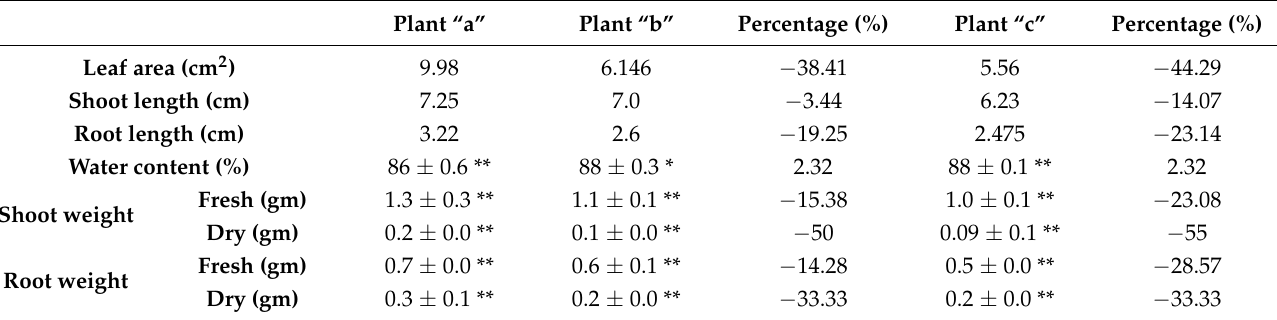
Table 1. Growth regulatory system of S. oleracea plant “a” plants “b” and plant “c.”.